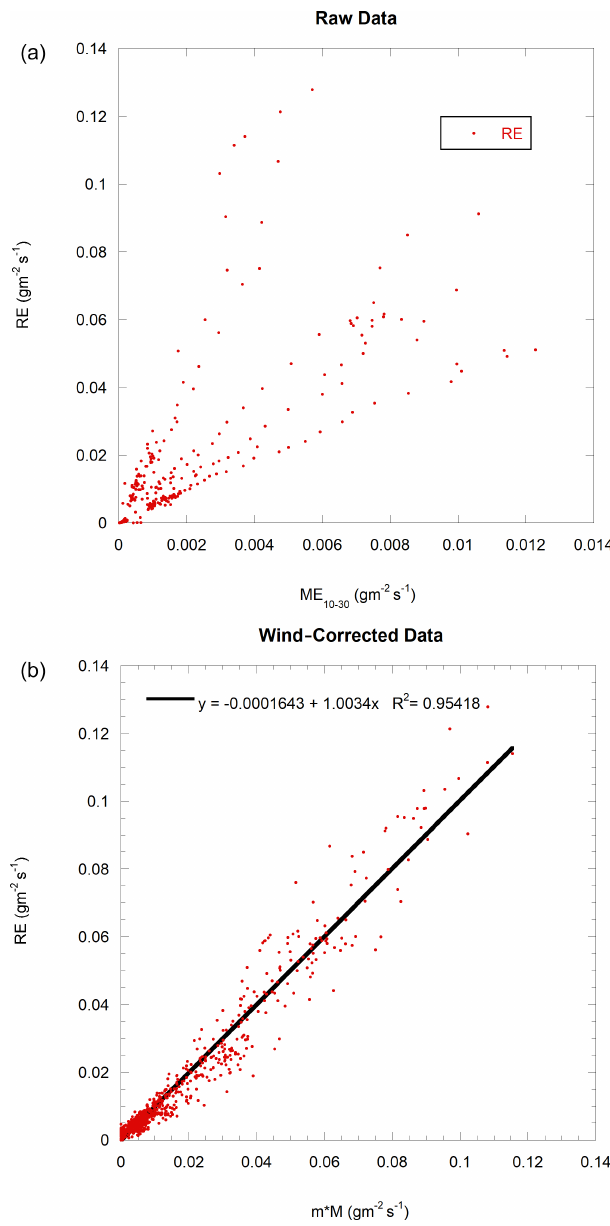
Figure 8. (a) RE versus ME (raw data, average between PWM = 10 and PWM = 30% measurements). (b) RE versus wind speed cor- rected ME for all disponible data along with a linear